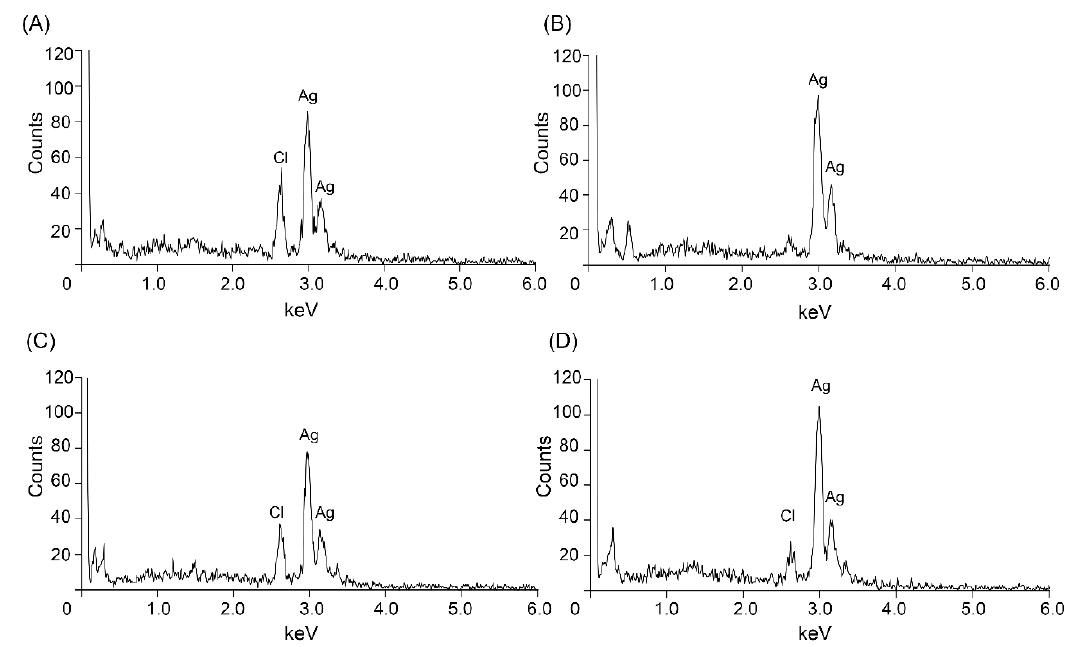
Figure 2. SEM images of silver/silver chloride nanoparticles (Ag/AgCl NPs) synthesized using ( A ) supernatant of Bti ; ( B ) solubilized inclusion proteins of Bti (mix toxins); ( C ) solubilized Cry4Aa protein; ( D ) solubilized Cry4Ba protein.